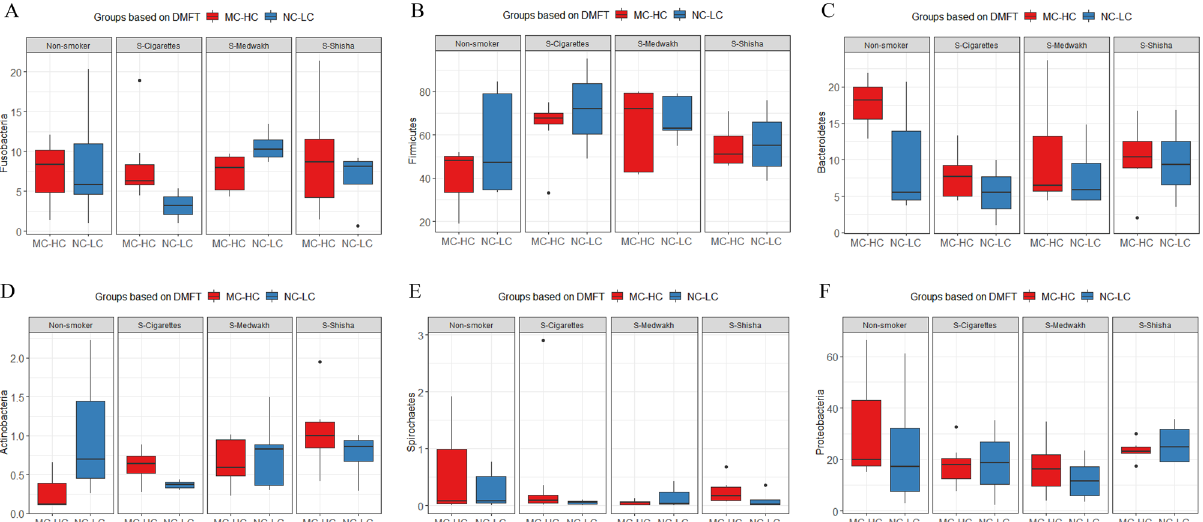
Figure 1. Comparison of the relative abundance (%) of the major phyla detected in the supragingival plaque samples; collected from subjects with no or low (NC-LC) caries and moderate-high (MC-HC) caries, in smokers of different types of tobacco and non-smokers. Box plots show Q1-median-Q3 with data range. Black dots are outlier